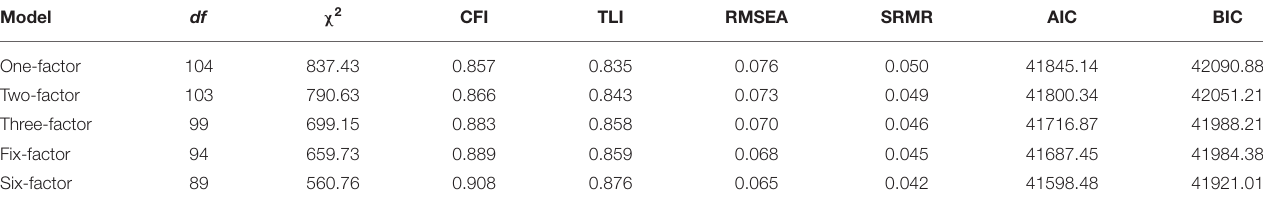
TABLE 3 | Model fit indices of models with different number of factors.